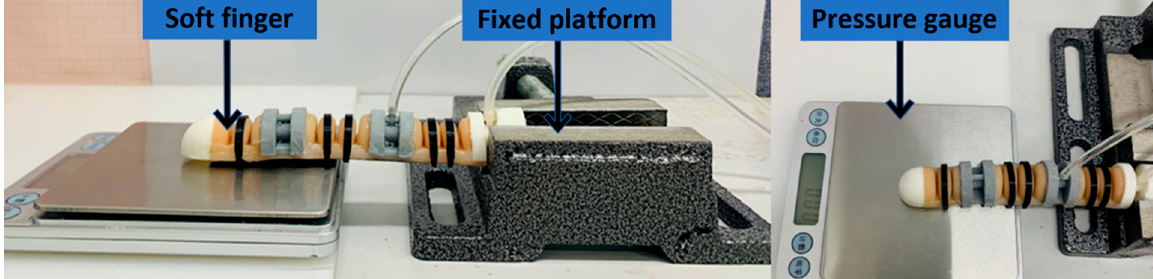
Figure 16. Soft fingertip output force experiment